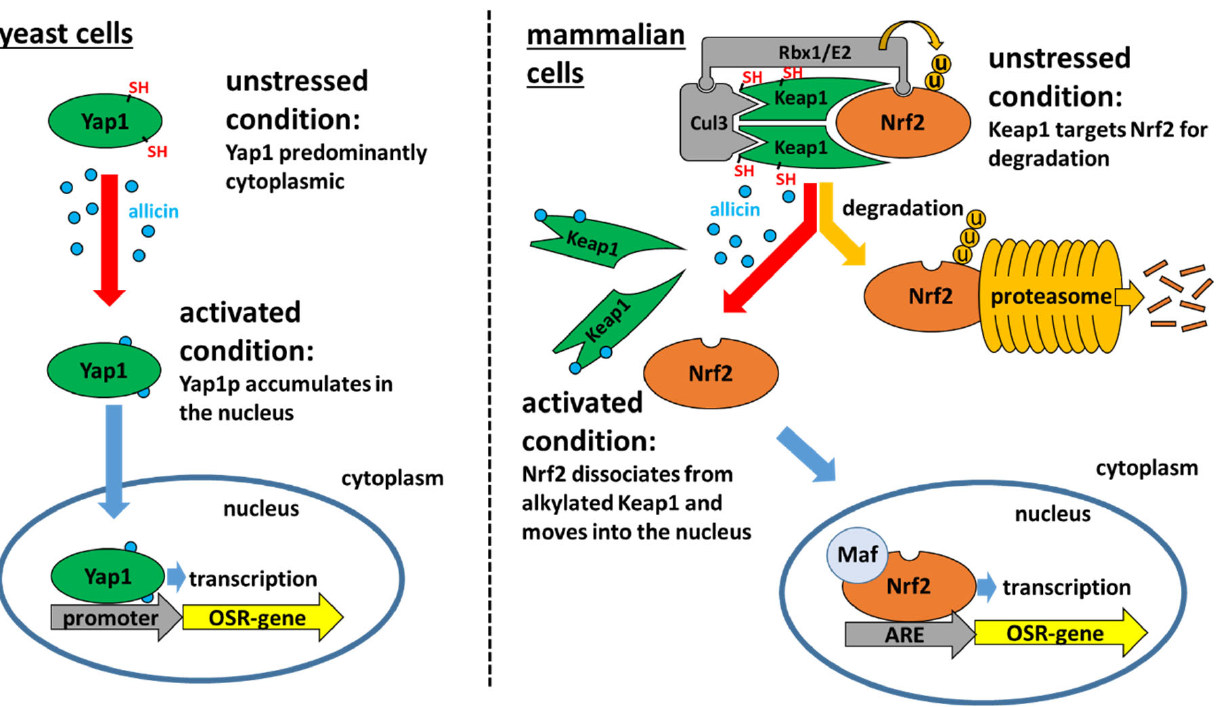
Figure 1. Sensing oxidative stress by specific thiol oxidation in yeast and mammalian cells. The sensing of low M r electrophilic oxidants that cause oxidative stress is predominantly based on the oxidation of sensitive cysteine thiols, e.g., in Yap1 in yeast and in Keap1 ‐ Nrf2 in mammals. Allicin stimulates the expression of OSR genes in both yeast and mammals by a similar mechanism.